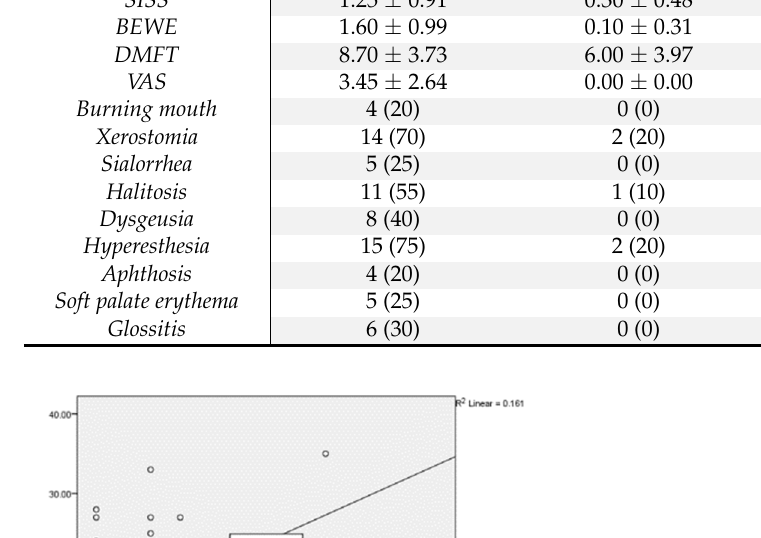
Figure 3. Oral pepsin levels correlated linearly with RSI scores ( p = 0.028).